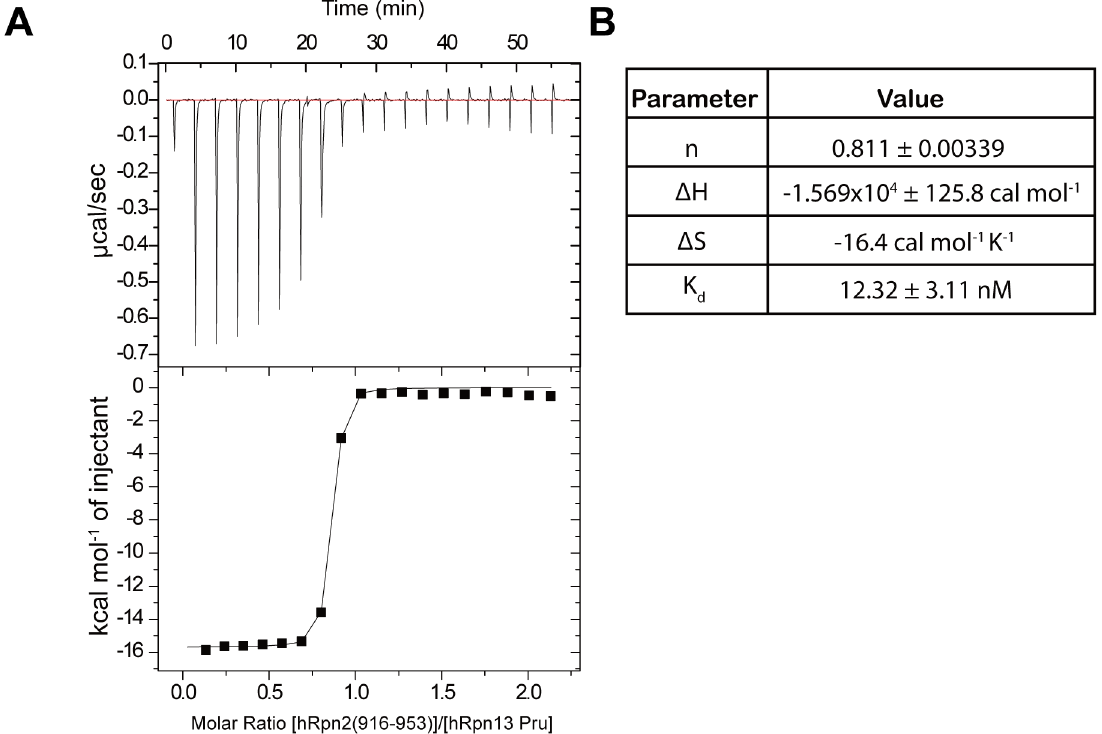
Fig 2. An hRpn2-derived peptide binds to hRpn13 Pru domain with 12 nM affinity. (A) 200 μ M hRpn2 (916 – 953) was injected into a calorimeter cell that contained 20 μ M hRpn13 Pru. The binding isotherm (top) was integrated to yield the change in enthalpy as a function of hRpn2 peptide (bottom). (B) The data fit well to a 1-site binding mode with the indicated thermodynamic